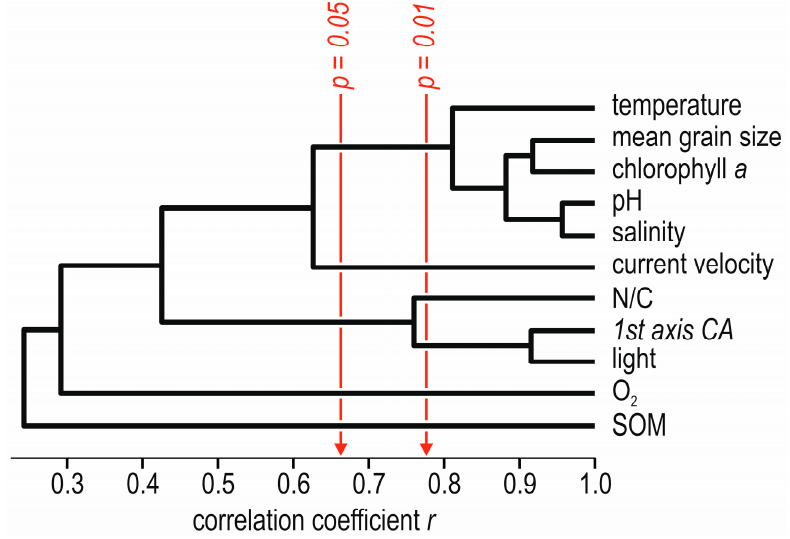
Figure 11. Dendrogram (minimum variance clustering) of the correlation coefficient r between the scores of the first axis from correspondence analysis, applied to the matrix of 15 decapod species × 10 stations in the Grotta Marina di Bergeggi, and a set of environmental parameters measured within the cave in the same stations where decapod species were recorded. p is the significance level.